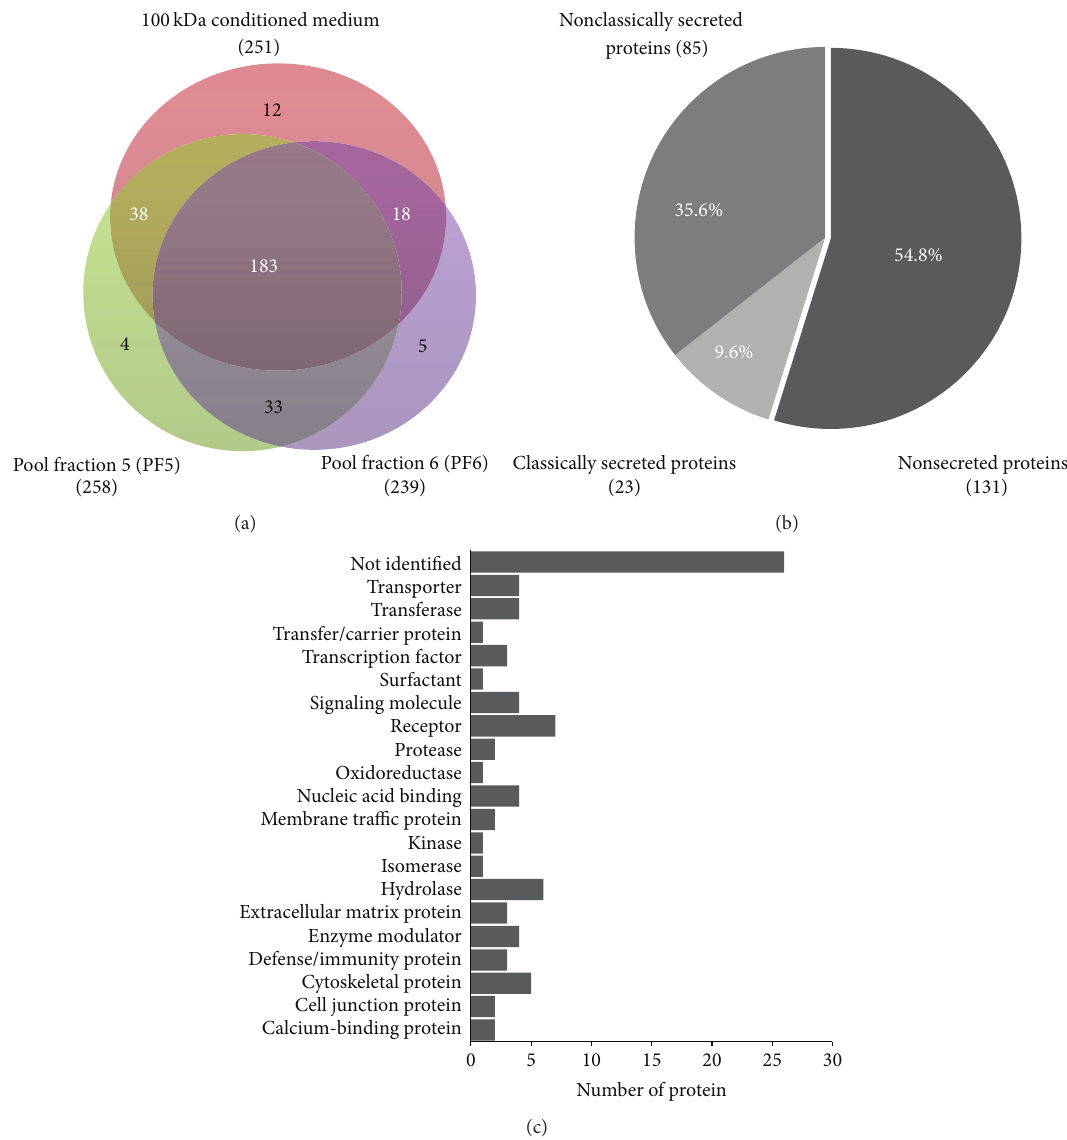
Figure 6: Characterization of PL-MSCs secretome. (a) Venn diagram illustrates the proteins presented in 100 kDa fraction of PL-MSCs conditioned medium as well as those presented in subfraction 5 and subfraction 6 of the 100 kDa fraction. Number of proteins presented in the 100 kDa fraction which were subsequently fractionated into subfraction 5 and/or subfraction 6 (labeled with white color) were regarded as candidate proteins. (b) Pie chart illustrates 239 candidate proteins which were further categorized into nonsecreted protein, classically secreted protein, and nonclassically secreted protein, by SignalP 4.1 and SecretomeP 2.0 software. (c) Graph demonstrates functions of 77 secretory proteins based on PANTHER classification and